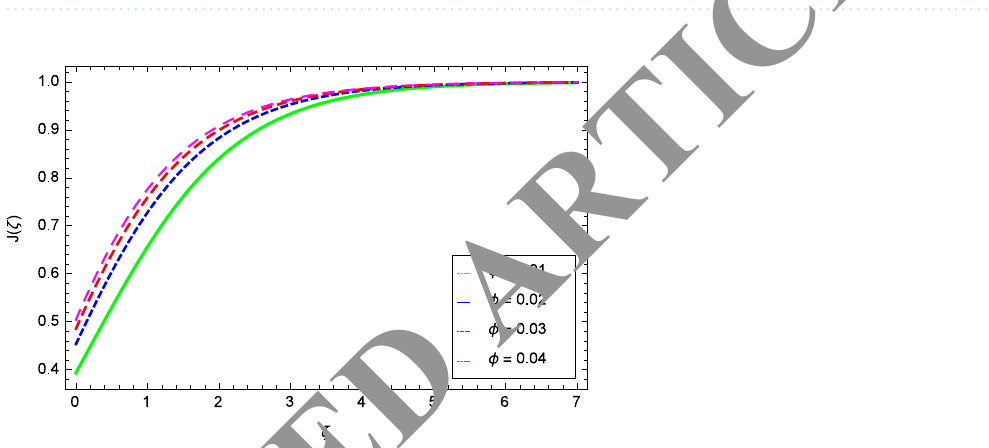
Figure 35. Effect of φ on concentration of chemical reaction J (ζ)